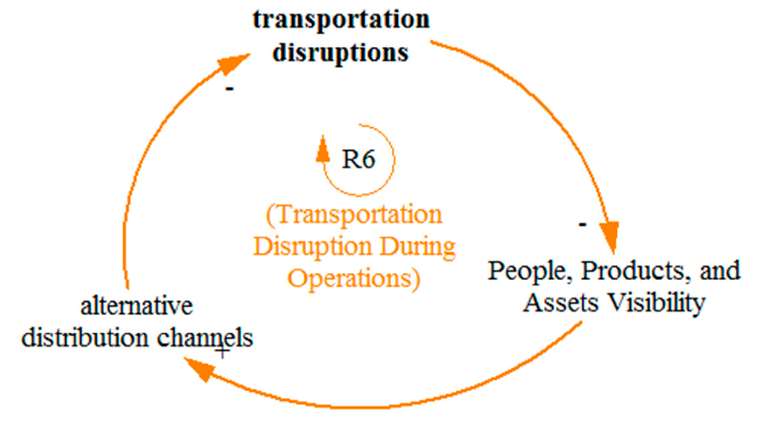
Figure 11. Reinforcing loop R6 (transportation disruption during operations).